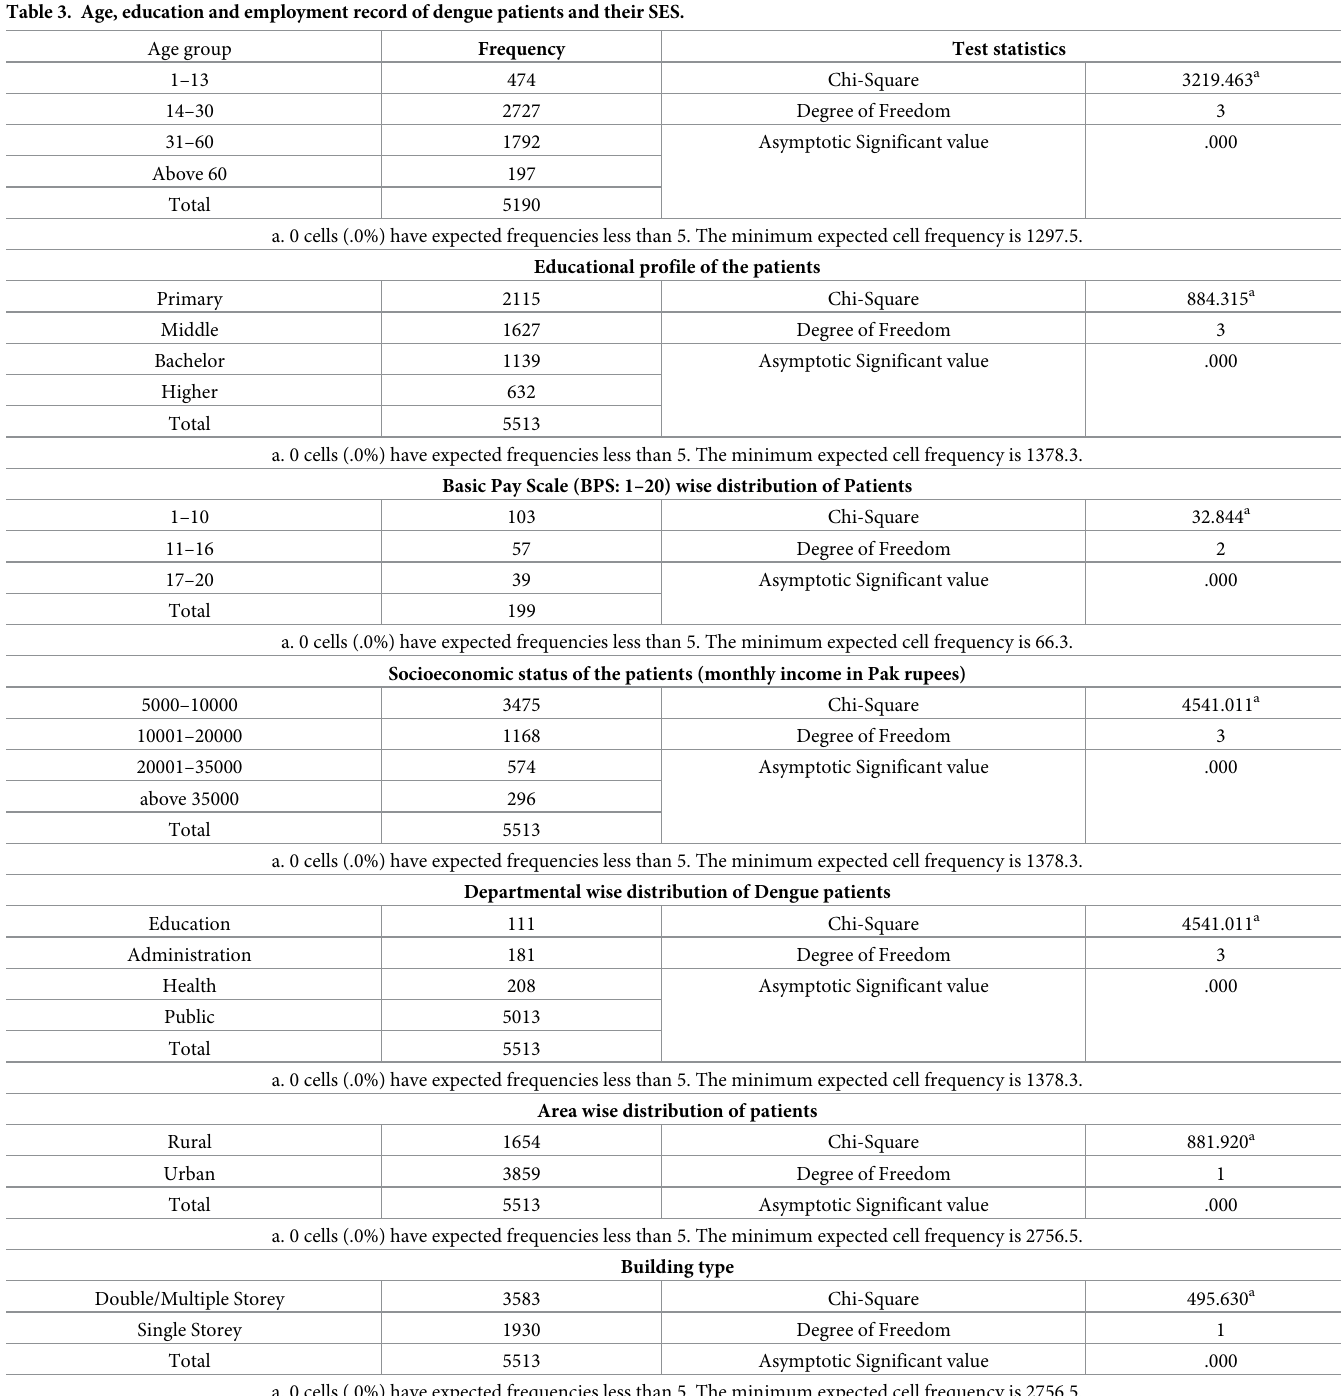
Table 3. Age, education and employment record of dengue patients and their SES.